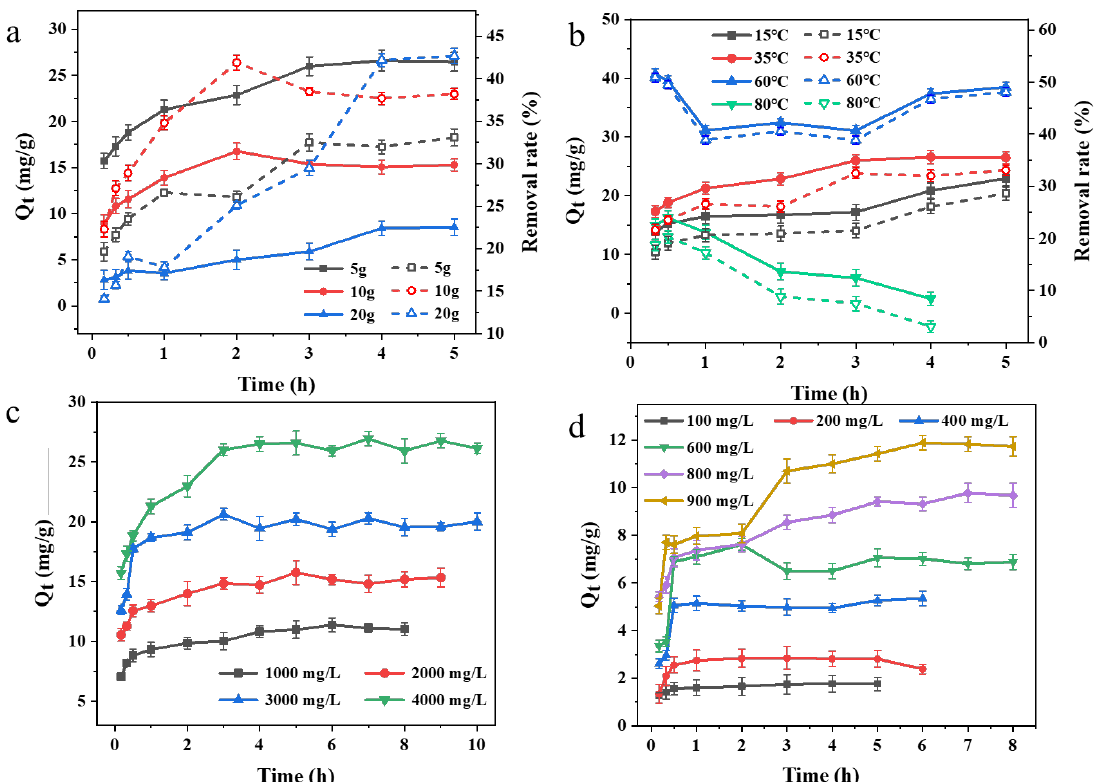
Figure 2. The effect of various treatment processes on the high-concentration ammonium removal. ( a ) Natural zeolite dosage; ( b ) Temperature; ( c ) High-concentration ammonium (1000~4000 mg-N/L) ( d ) Low-concentration ammonium (<1000 mg-N/L). The solid lines and dotted lines represent the adsorption capacities of the natural zeolite and the ammonium removal percentages, respectively in Figure